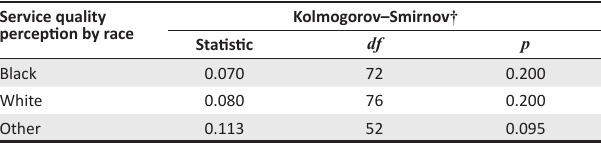
TABLE 8: Results of the independent sample t -test. Service quality perception variances Equal variances assumed